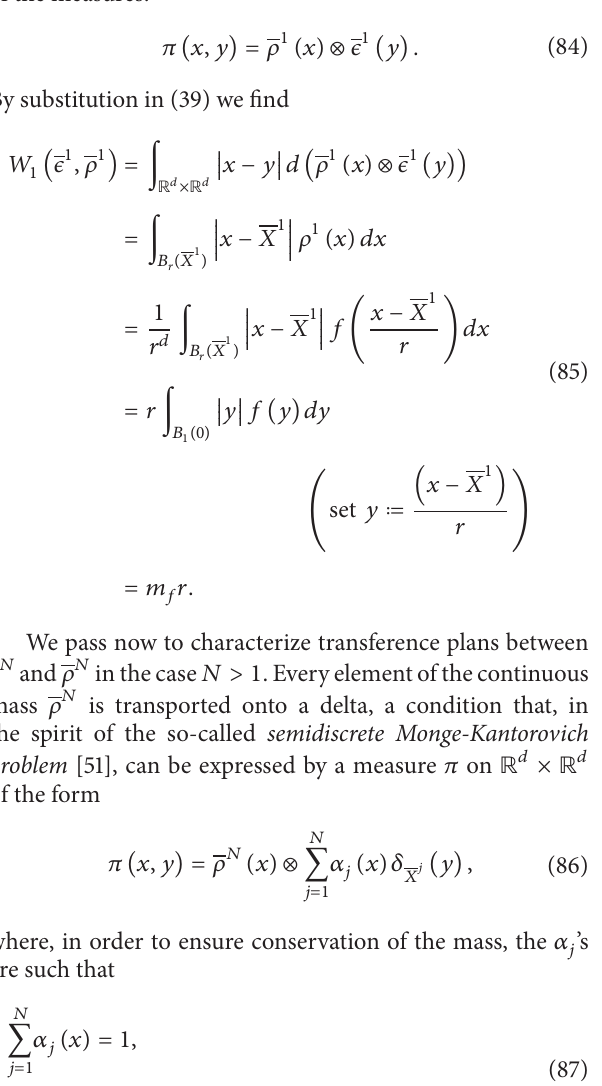
𝑁 𝑁 and 𝜌 , because it is 𝑁 with respect to 𝑦 .